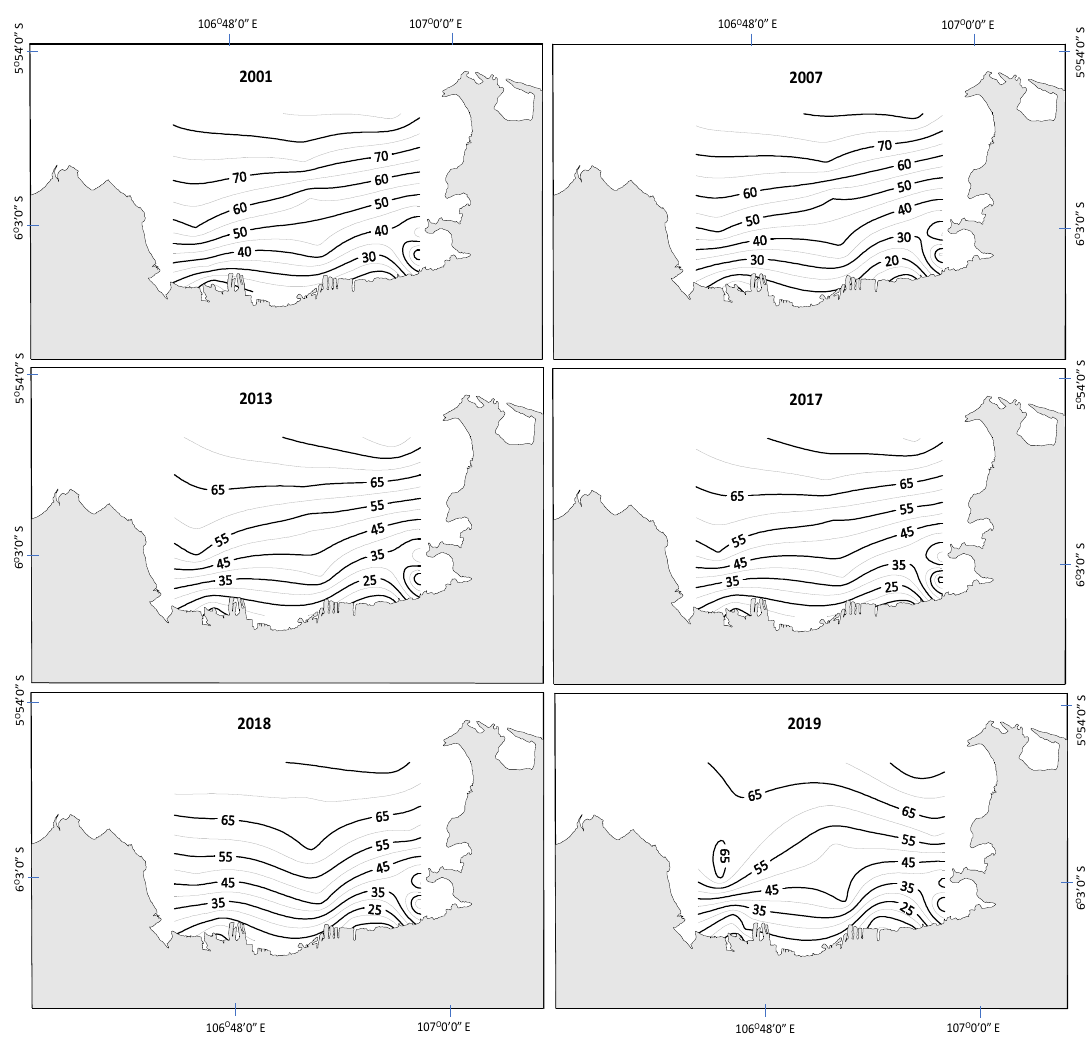
Figure 6. Spatial distribution of the mean of underwater light level (µmol photon m −2 s −1 ) in Jakarta Bay.